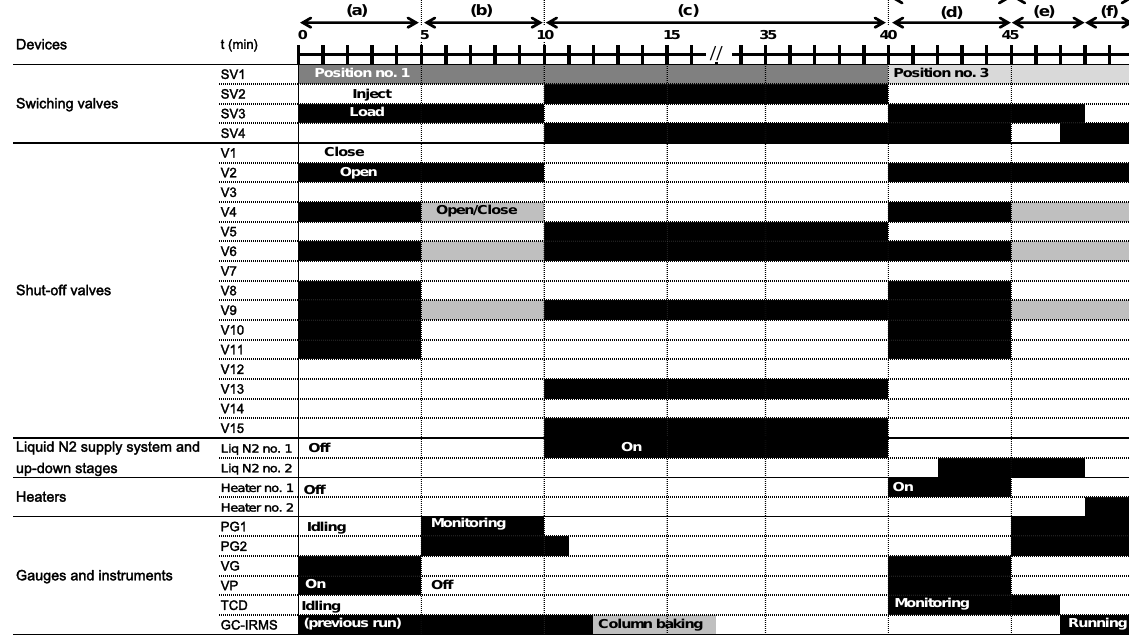
Figure 2. Time sequence of the sample preparation procedure. Horizontal arrows on the top indicate the periods for evacuation of the inlet line (a) , sample injection (b) , cryogenic concentration of N 2 O on T1 (c) , purification of N 2 O by GC1 (d) , cryofocusing of N 2 O on T2 (e) , and injection of N 2 O into GC2 (f) . See also Fig.